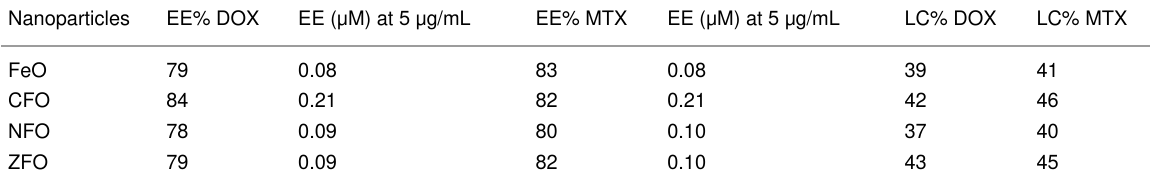
Table 6: Encapsulation efficiency (EE) and loading capacity (LC) of MFe 2 O 4 (M = Fe, Co, Ni, Zn) nanoparticles. Nanoparticles